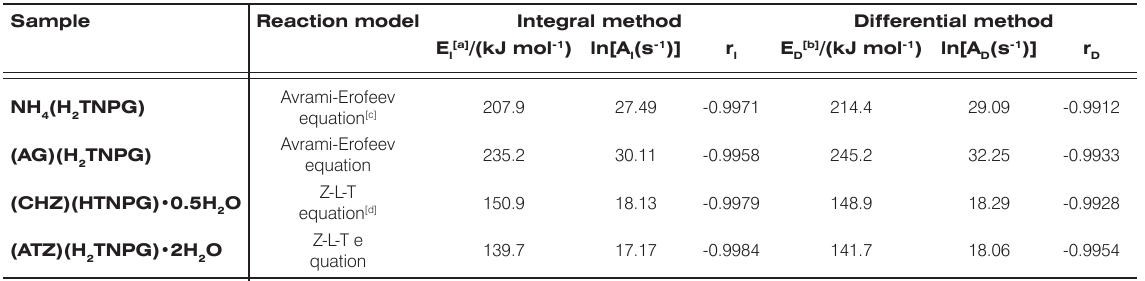
(H TNPG), (AG)(H 4 2